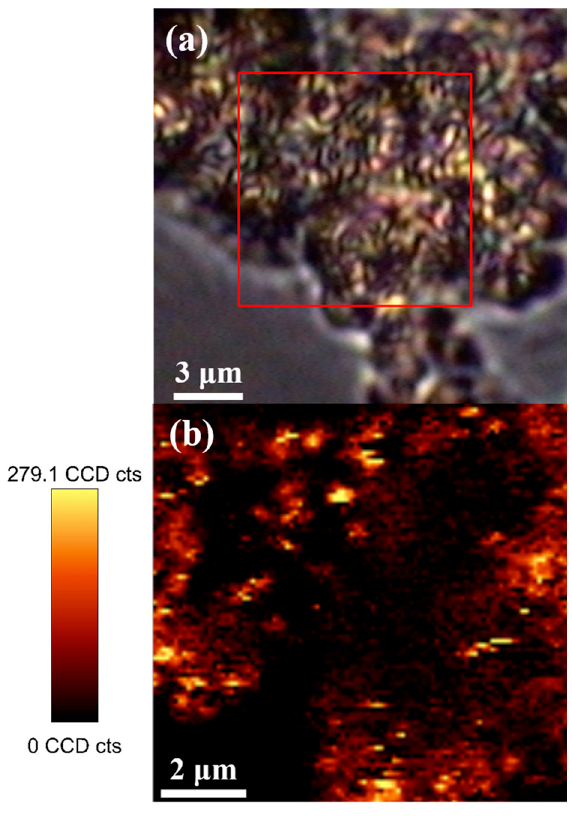
Figure 7. ( a ) Optical image of the sample with the Raman scanned area marked in red; ( b ) Raman image obtained using the integrated intensity of the PG band at 1000 cm − 1 , over a surface area of 10 × 10 µ m in MNP-Au(102), by placing a drop of aqueous solution of PG (10 − 4 M) (excitation at 633 nm, 500 μ W laser power, 100 points per line × 100 lines per image, 0.2 s). The vertical bar on the left of the Raman image shows the color profile and the relative intensity scale of the band at 1000 cm − 1 .